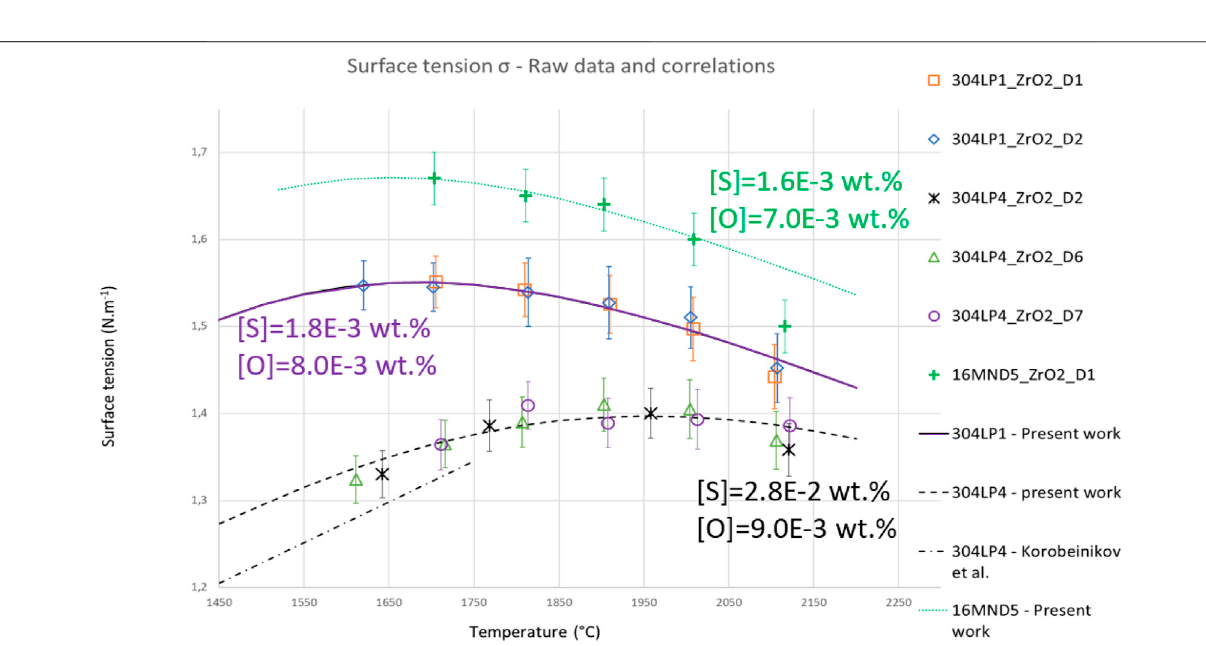
Frontiers in Energy Research |